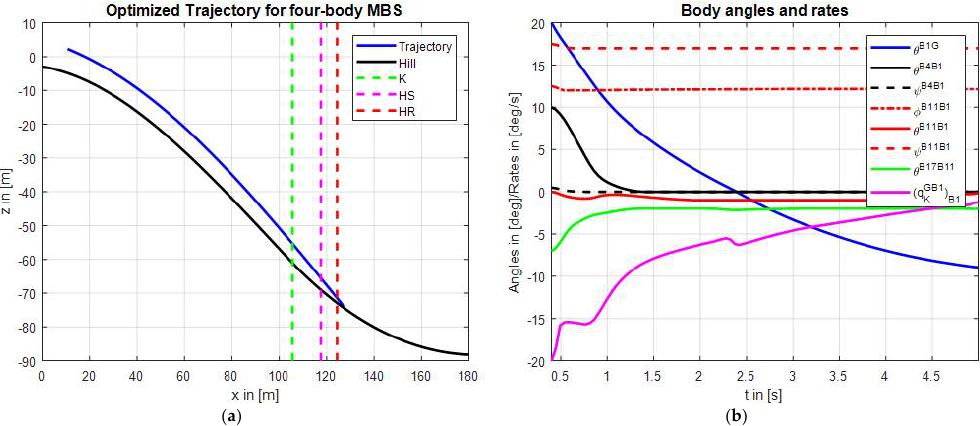
Figure 4. Optimized trajectory ( a ) and body angles and upper body rate over the flight time ( b ) for four-body MBS on Okurayama